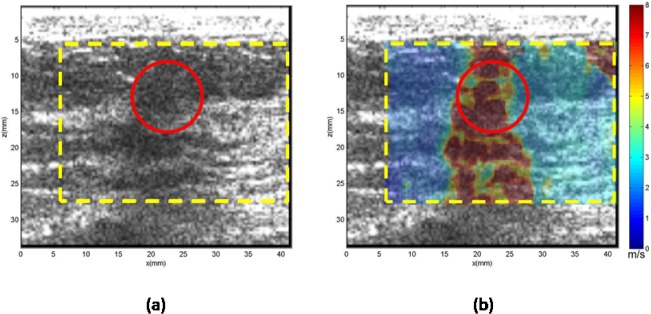
US and CUSE shear wave speed map of breast tissue (dashed yellow contour) including the breast mass ROI (red contour).(a) B-mode US image. (b) CUSE shear wave speed map. The vertical extensions of the high shear wave speeds along the mass location demonstrate the effects of calcifications.